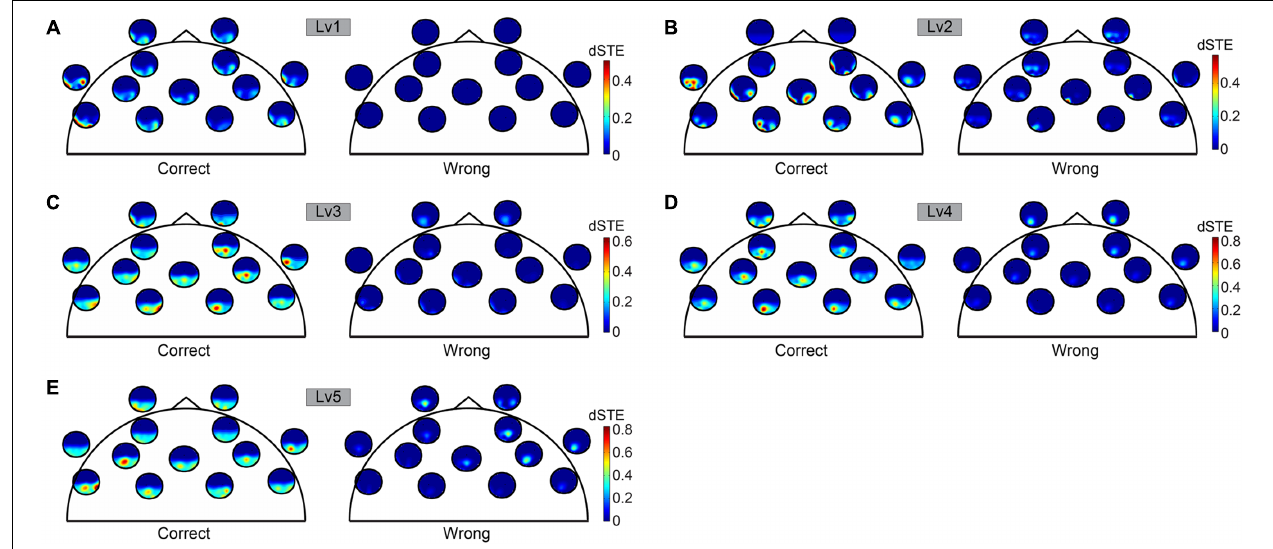
FIGURE 6 | To represent dSTE for each of the five cognitive workload levels [(A) Lv1, (B) Lv2, (C) Lv3, (D) Lv4, and (E) Lv5] and in both correct (left panel) and wrong trials (right panel), we adopted a novel visualization scheme, in which the relative position of a single sensor u is used to embed a whole brain’s topography that represents the dSTE(u,v) measurements related to it. A minute topography depicts the dSTEs from a particular sensor to all other destinations (sensor locations). It serves as a natural display of a row in the dSTE matrix. The topographic representation illustrates only the Frontal sensors because (cid:49) dSTE uncovered F θ brain region as a leader.